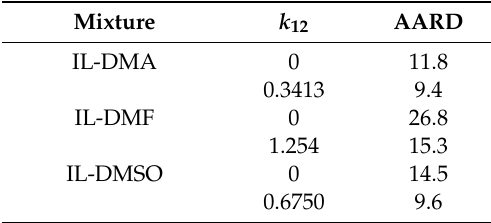
Table 16. The parameters k 12 for the hard-sphere theory in Equation